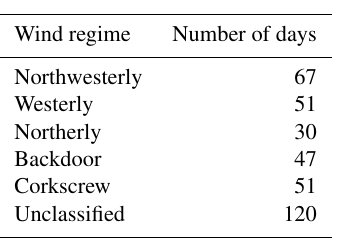
Table 2. Number of days for each wind regime from the 1-year WRF